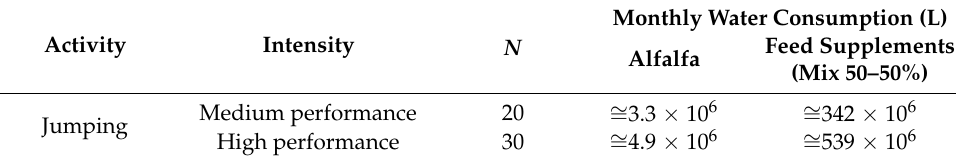
Table 2. Monthly water consumption (L) for animal feed. N : samples number.